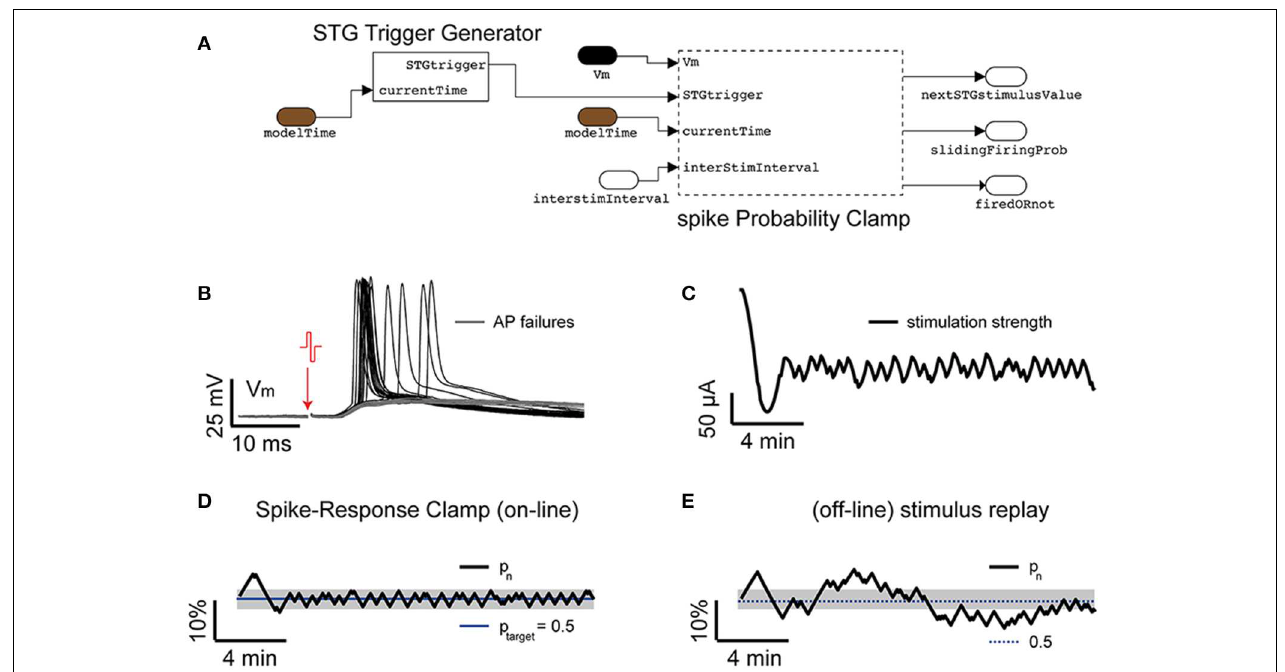
spikeProbabilityClamp to the protocol of Figure 2 , the intensity of a repeated extracellular current-controlled electrical stimulation is automatically regulated in real-time (C) to maintain the probability of eliciting an action potential to a desired value (D) . However, as soon as the sequence of commands is replayed in open loop (E) , the response probability displays larger fluctuations. Commonly used values were P pid = 1 , I pid = 0 . 3 , G = 700